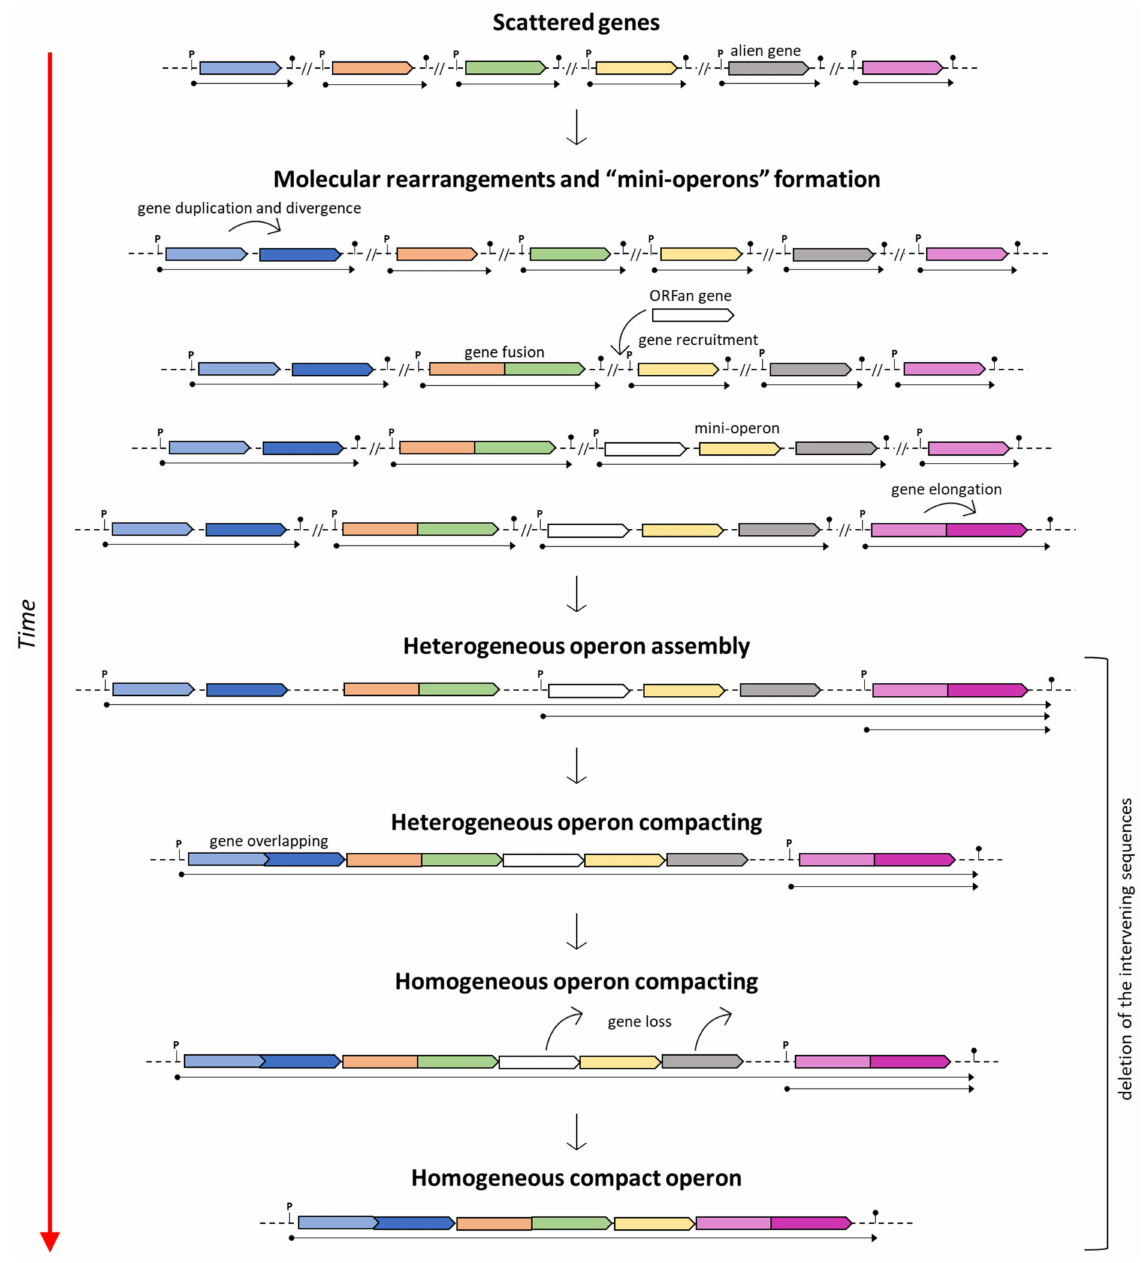
Figure 1. The piecewise model for the operon formation. Adapted from